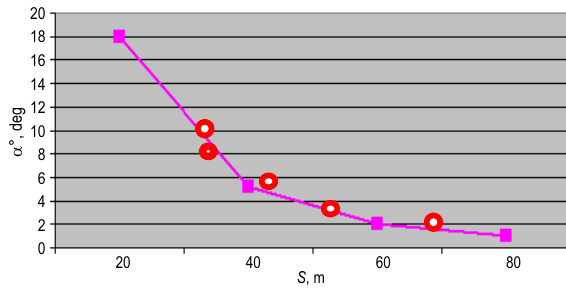
Fig. 16. The results of hydrodynamic interactions between similar sizes of the ships in narrow channels received experimentally on the ferry Princess Anastasia and with reference to calculation results